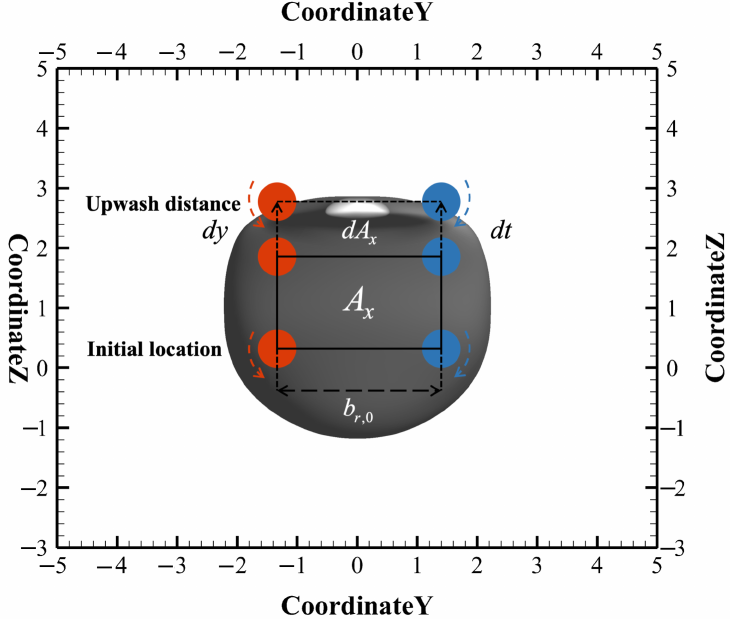
Figure 9. The vorticity loop